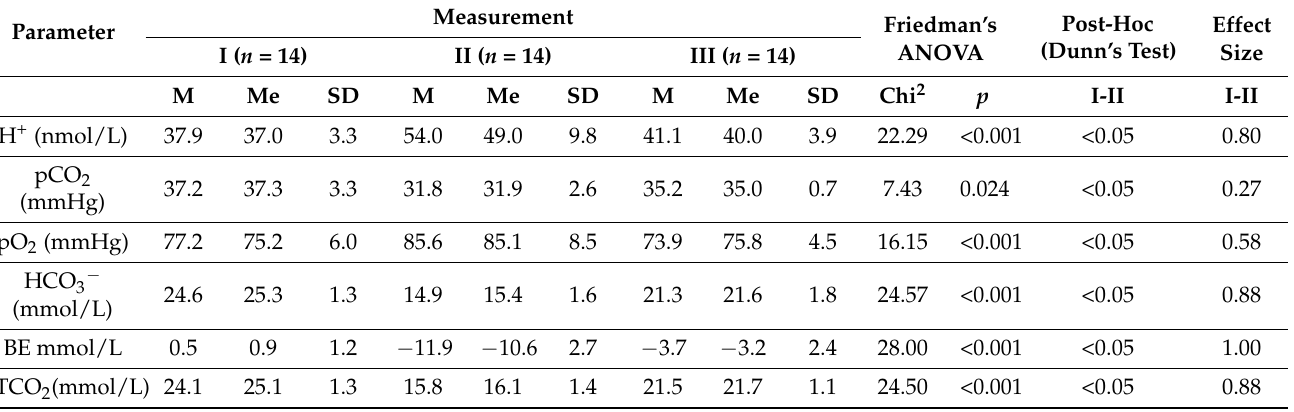
Table 2. The level of acid–base balance parameters in the tested group of athletes in three consecutive measurements.